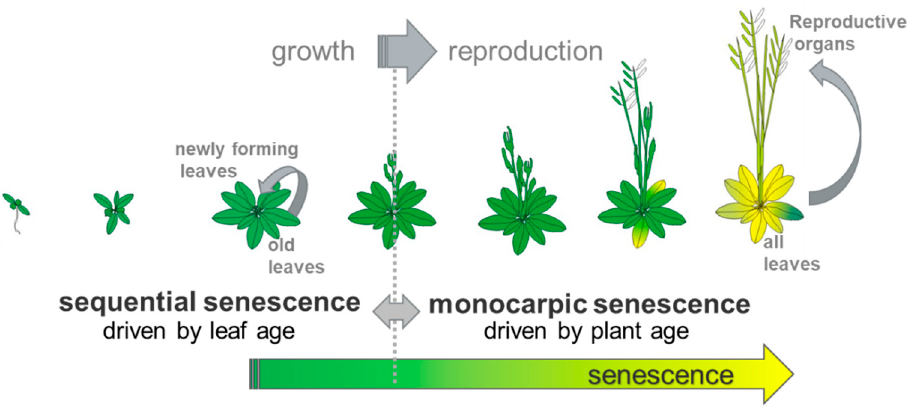
Figure 1. Leaf senescence in the model plant Arabidopsis thaliana . Leaf senescence takes place all over development. At the transition from the growth to reproduction phase, senescence is switched from sequential to monocarpic senescence.